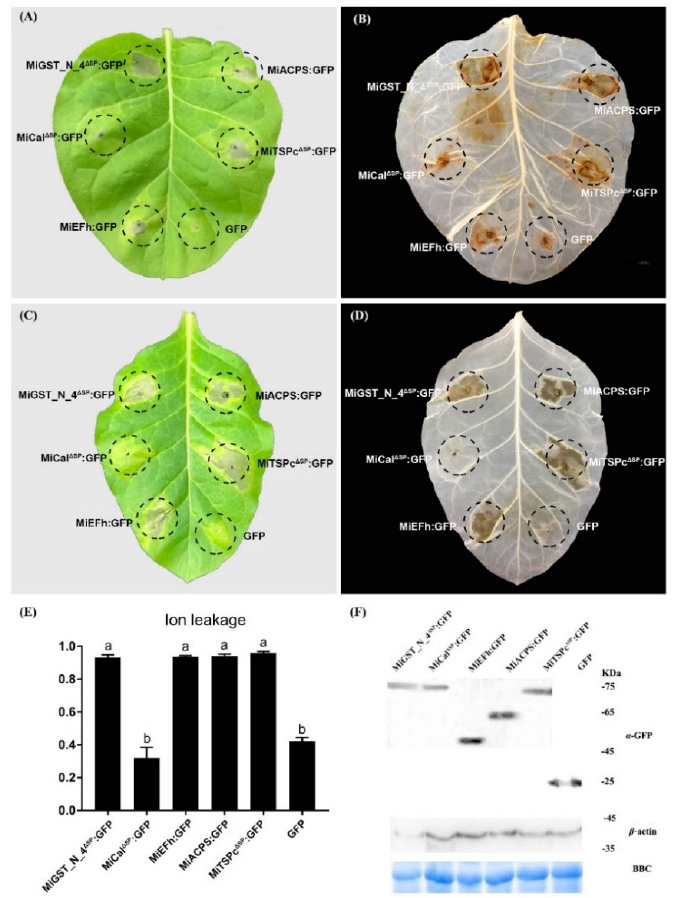
Figure 7. Analysis of ROS and HR after inoculation of five effectors in the RKN ‐ resistance tobacco variety K326. The experiment was repeated at least three times, and each assay consisted of at least five plants with three leaves inoculated similarly. ( A , C ) shows a representative leaf of A. tumefaciens GV3101 harboring the vectors of MiGST_N_4 Δ SP : GFP, MiCal Δ SP : GFP, MiEFh: GFP, MiACPS: GFP, and MiTSPc Δ SP : GFP constructs injected into the RKN ‐ resistance tobacco variety K326. The HR oc ‐ curred in the leaf at the injection position of 5 days after inoculation with the effector. Five repre ‐ sentative leaves were photographed after 5 days. OD 600 = 1. ( B ) Leaves cleared with 3,3 ′‐ diamino ‐ benzidine blue (DAB). The brown area represents H 2 O 2 localization. ( D ) leaves cleared by ethanol injected with effectors after 5 days. ( E ) Ion leakage (mean ± SE, n > 5) was measured 72 h after effector injection in the RKN ‐ resistance tobacco variety K326. Error bars represent ± SD of three independent experiments. Letters a ‐ b on the bars indicate significant differences ( p < 0.05) between samples. Dif ‐ ferent letters indicate significant differences based on one ‐ way analysis of variance (ANOVA) fol ‐ lowed by Duncan’s multiple range test. ( F ) Normal expression and accumulation of all tested pro ‐ teins in plant cells as indicated by Western blotting analysis. Coomassie brilliant blue (CBB) staining was used to show equal up ‐ sampling of protein samples.